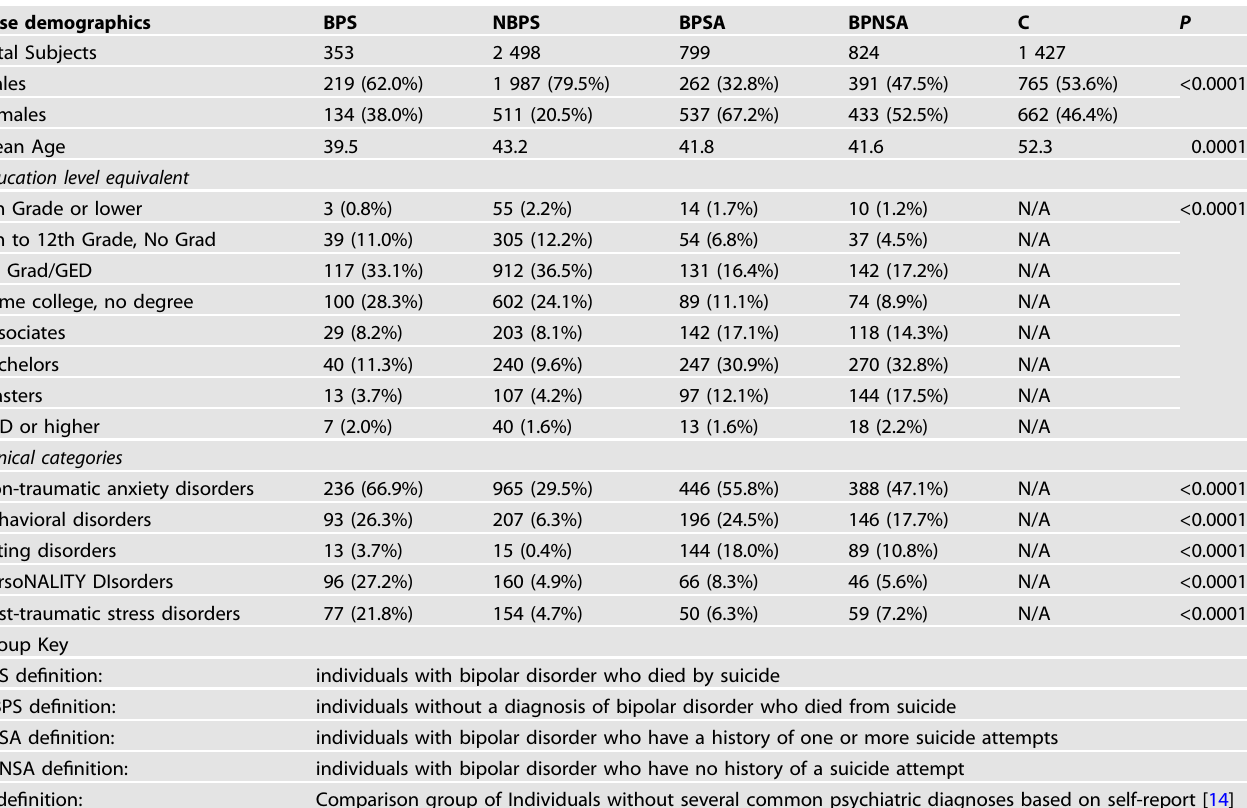
Table 1. Study sample demographics by comparison group.